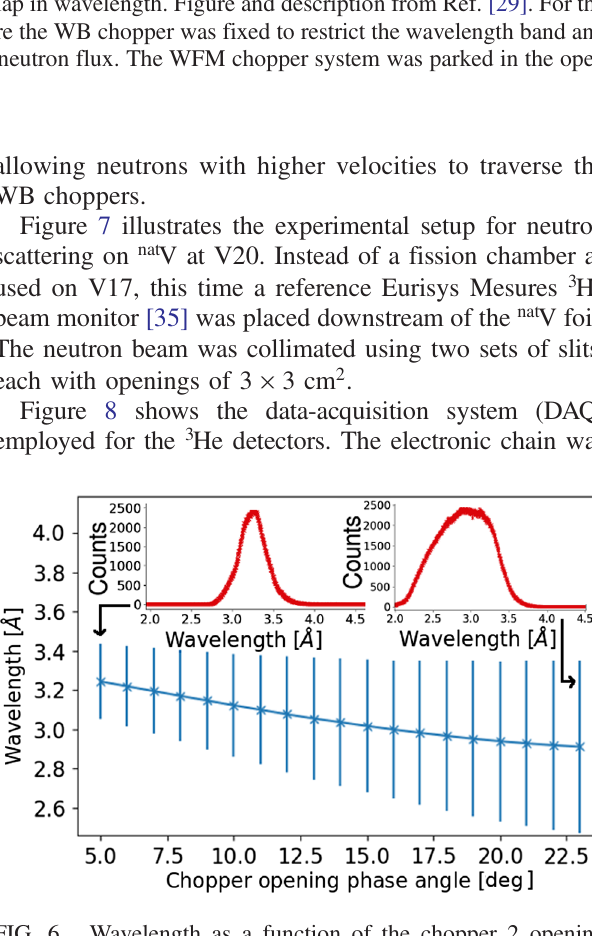
FIG. 6. Wavelength as a function of the chopper 2 opening phase angle. The blue crosses show shows the central wavelength of the wavelength bands recorded by the reference Eurisys Mesures 3 He beam monitor, the vertical blue bars represent the FWHM of the wavelength